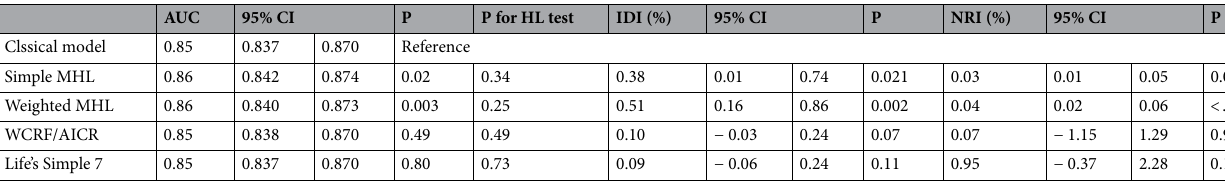
Table 4. Improvement in discrimination performance and calibration for risk prediction of cardiovascular events in the multivariate-adjusted model after including simple Mediterranean diet related healthy